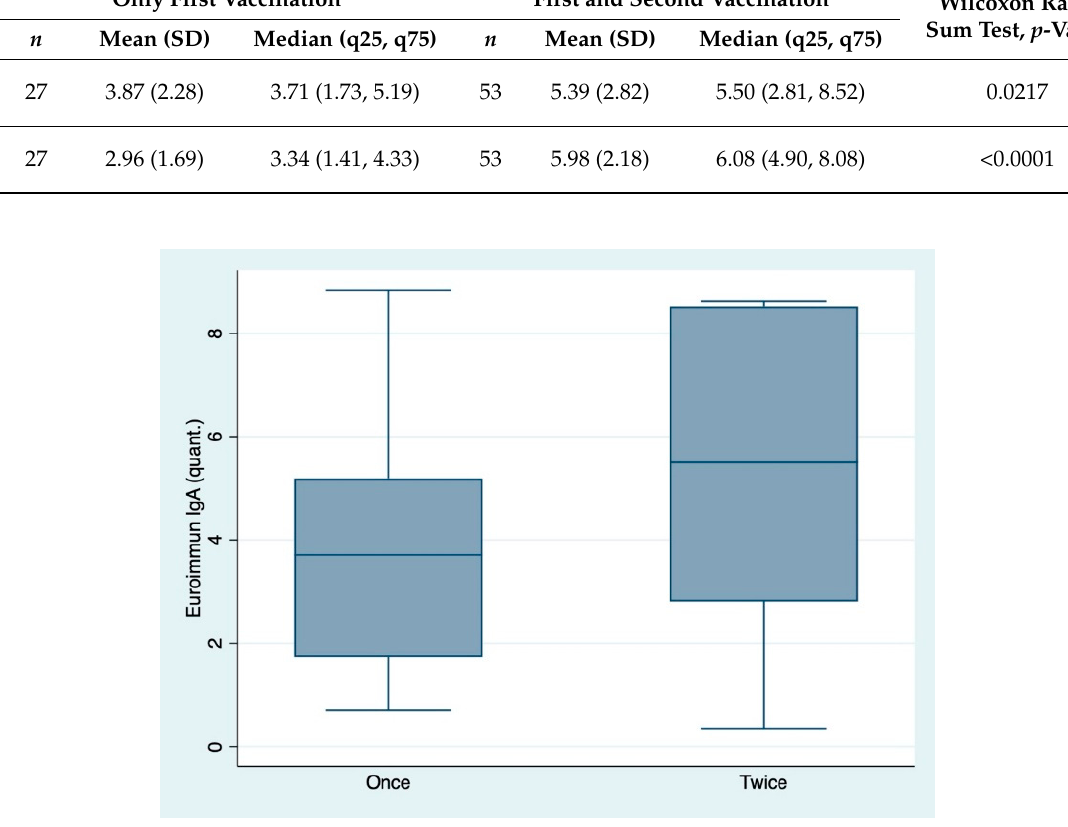
Figure 1. Box-plots indicating the difference of IgA antibody titers (as ratio of the patient sample over the extinction of the calibrator) among individuals who received one or two vaccinations. “quant.”: quantitative IgA titers. Once: one vaccination only. Twice: two vaccinations.